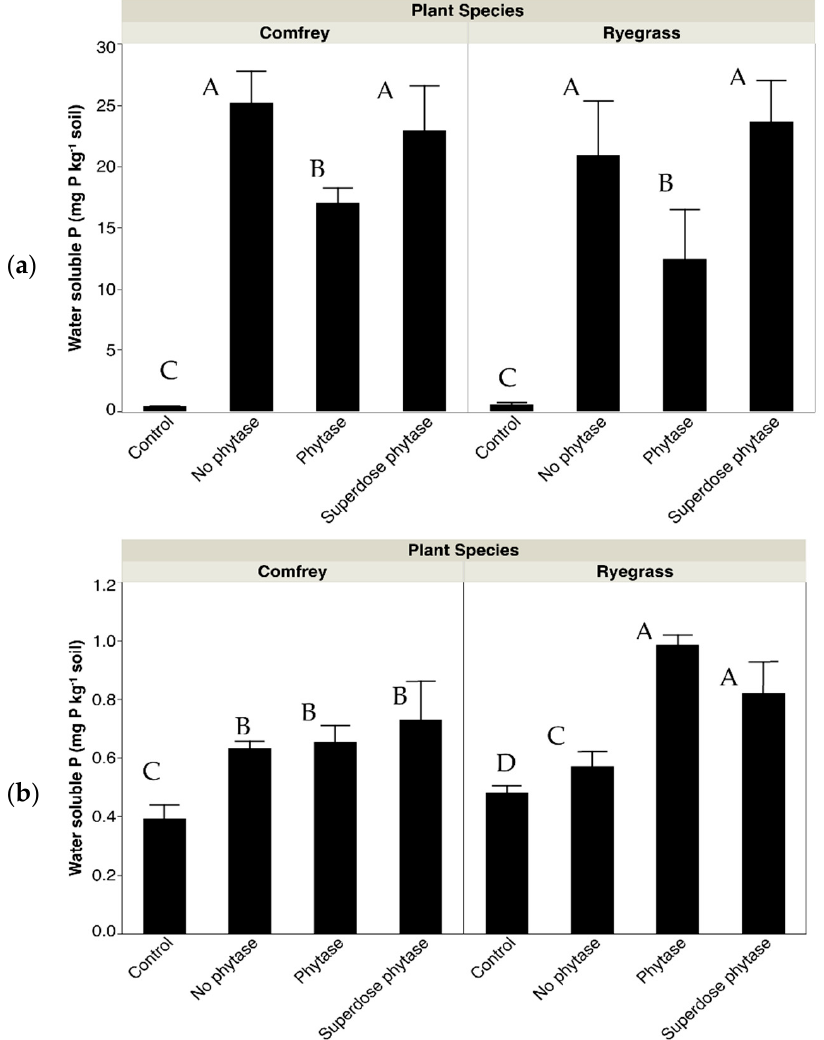
Figure 3. Effects of two different organic amendments ( a ) pig slurry and ( b ) broiler litter from different animal diets on soil available P (i.e., WSP) of two different plant species comfrey ( Symphytum × uplandicum ) and Italian ryegrass ( Lolium multiflorum ). Animal diets include: control = only inorganic fertiliser applied once (i.e., one dose of triple super P initially applied to support seedling growth), no-phytase, phytase and superdose phytase. Different letters indicate significant differences among treatments (Tukey HSD test).